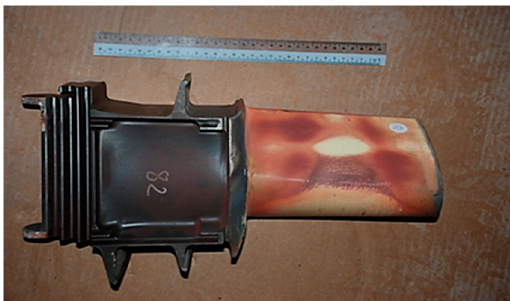
Figure 3. Gas turbine blade GTD 111.